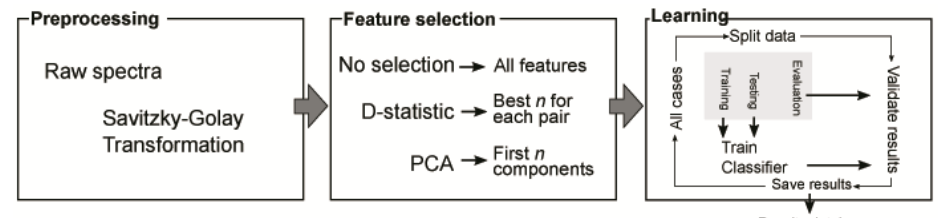
Figure 2. Data processing procedure.